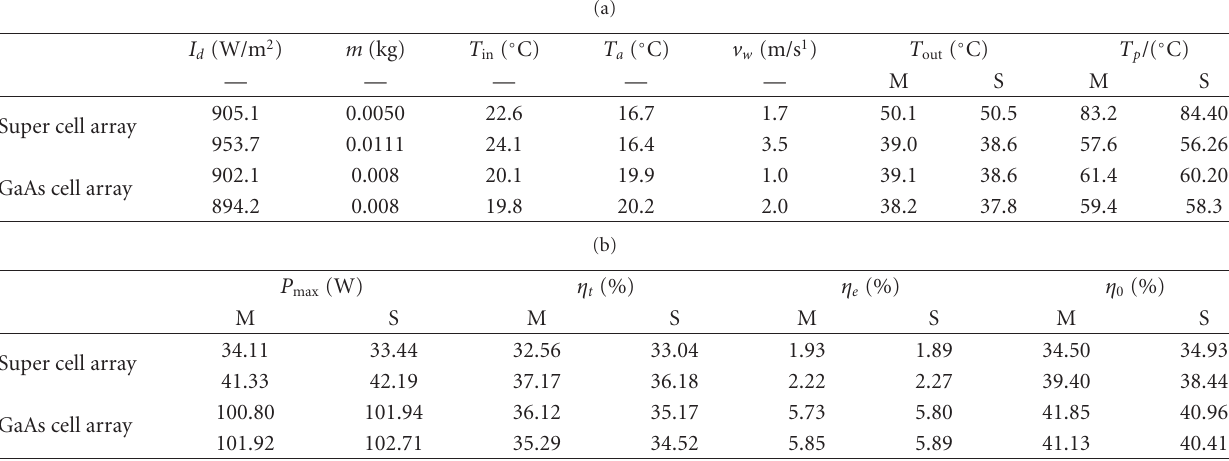
Table 2: The theoretical calculation results and the experimental results of the TCPV/T system.